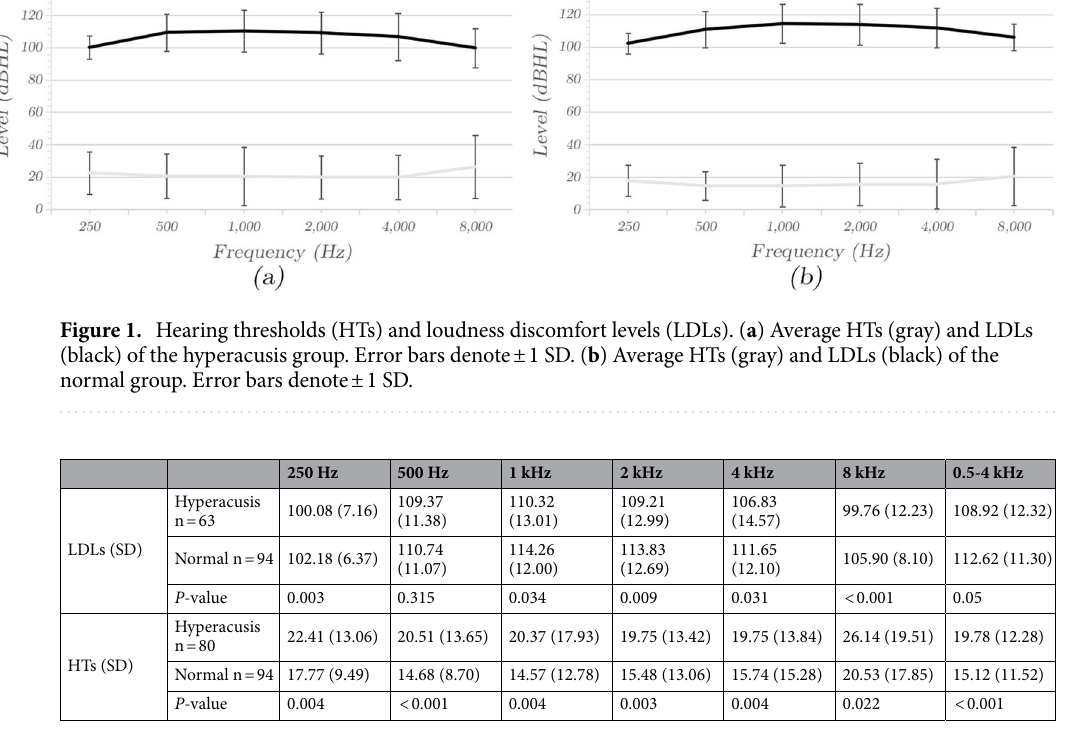
Table 3. Comparison of the average LDLs and HTs for the hyperacusis and normal groups at different frequencies (Note. The number of ears included in each analysis is indicated by n.